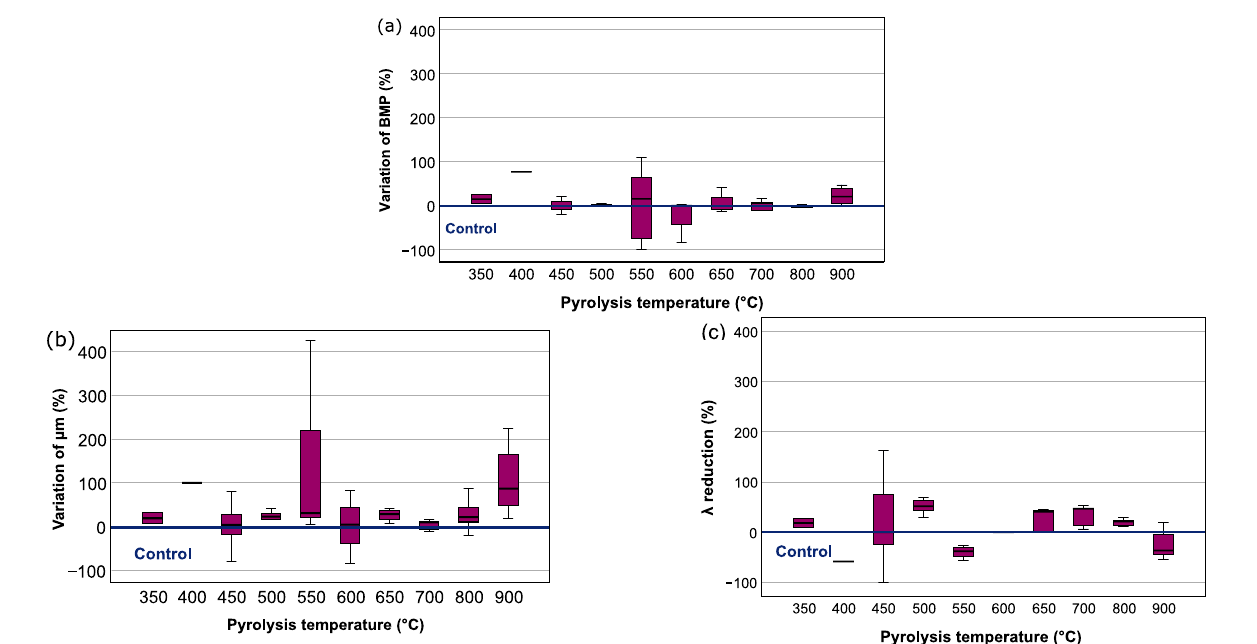
Figure 3. Box plot for the distribution of the effect of pyrolysis temperature used for producing the biochar added to anaerobic digestion, described by the relationship with BMP ( a ); µm ( b ), and λ reduction ( c ).